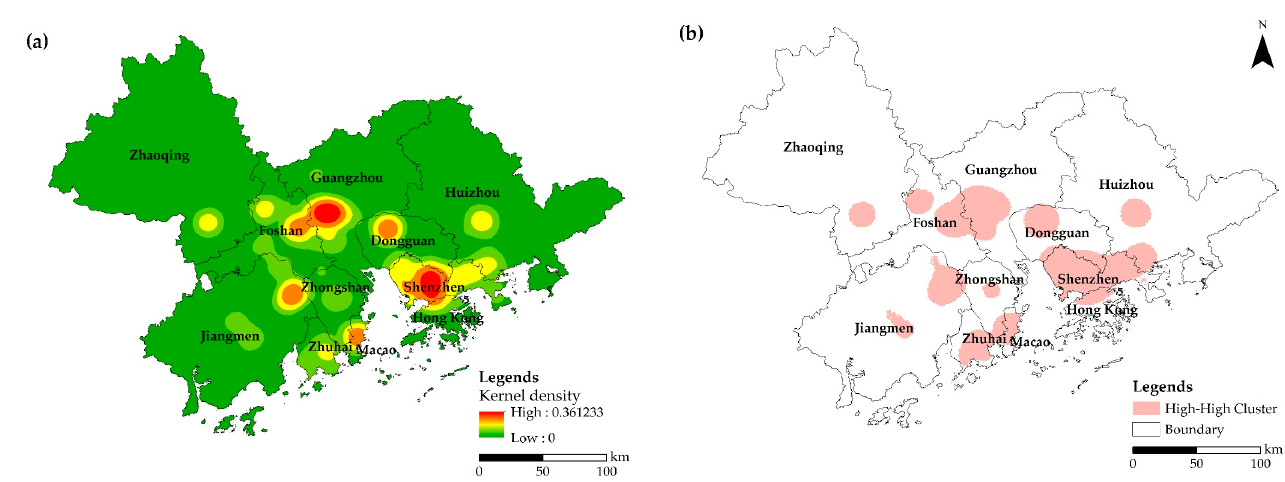
Figure 4. The spatial distribution of rainstorm waterlogging spots in the GBA from 2013 to 2017: ( a ) kernel density distribution; ( b ) cluster map.